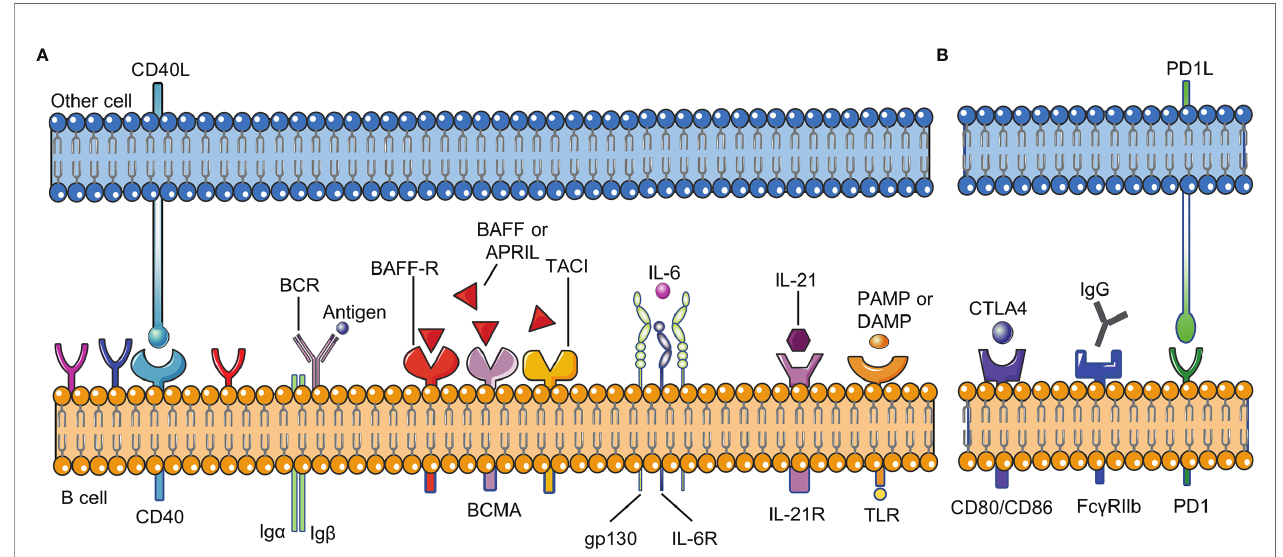
FIGURE 2 | B cell checkpoints in RA. B cell checkpoints provide signals for the survival, development, differentiation, inhibition and other physiological processes of all B cells. (A) stimulatory checkpoint. (B) inhibitory checkpoint. BCR,B cell receptor; CD40L, CD40 ligand; BAFF, B cell activating factor; BAFFR, B cell activating factor receptor; DAMP, damage- associated molecular pattern; PAMP, pathogen- associated molecular pattern; Fc g RII b , Fc gamma receptor II b ; IL-21R, IL-21 receptor; IL-6R, IL-6 receptor; PD1, programmed cell death 1; CTLA4, cytotoxic T lymphocyte-associated